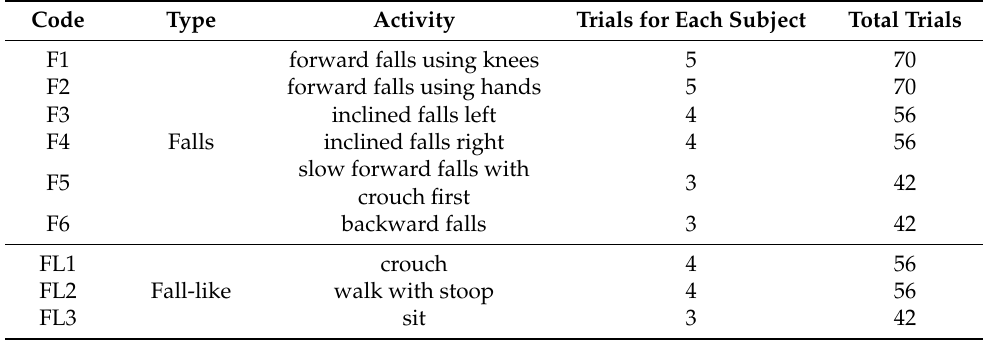
Table 2. Details of activities recorded in the dataset.